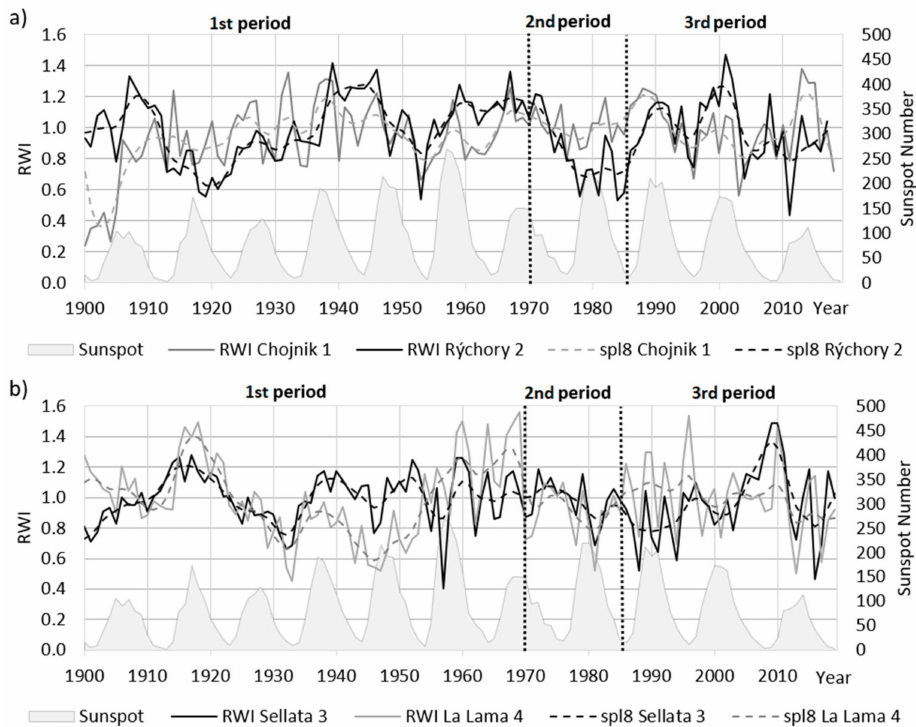
Figure 2. Standardized ring width chronologies of European beech on research plots in the Czech Republic/Poland ( a ) and in Italy ( b ). RWI: ring width index; spl8: eight-year spline. The periods described in the time window are as follows: 1st period: 1900–1969 (regular harvesting period); 2nd period: 1970–1985 (air pollution crisis period); 3rd period: 1986–2019 (forest protection